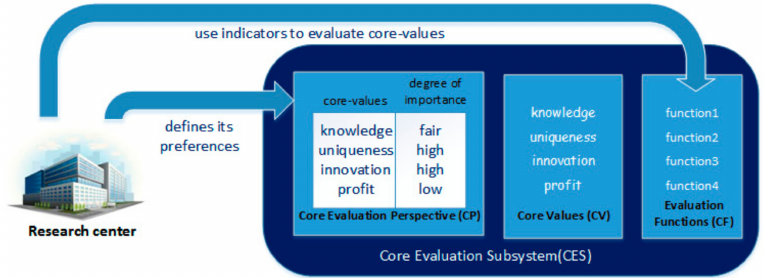
Figure 1. Example of Core Evaluation